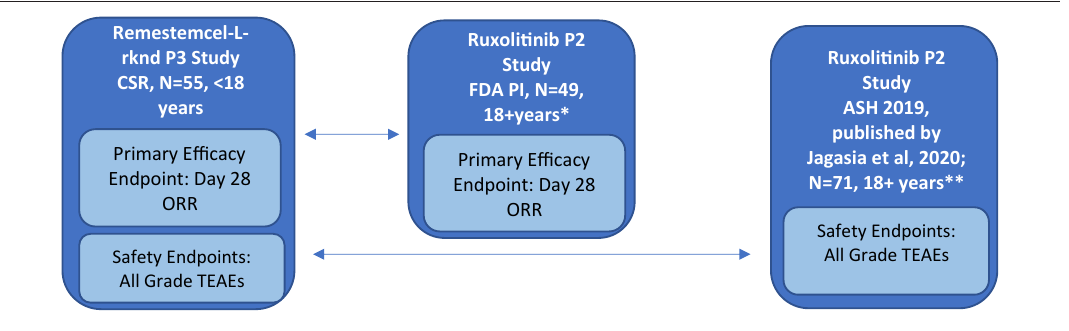
Figure 1. Clinical Studies and Data Sources for Comparative Effectiveness